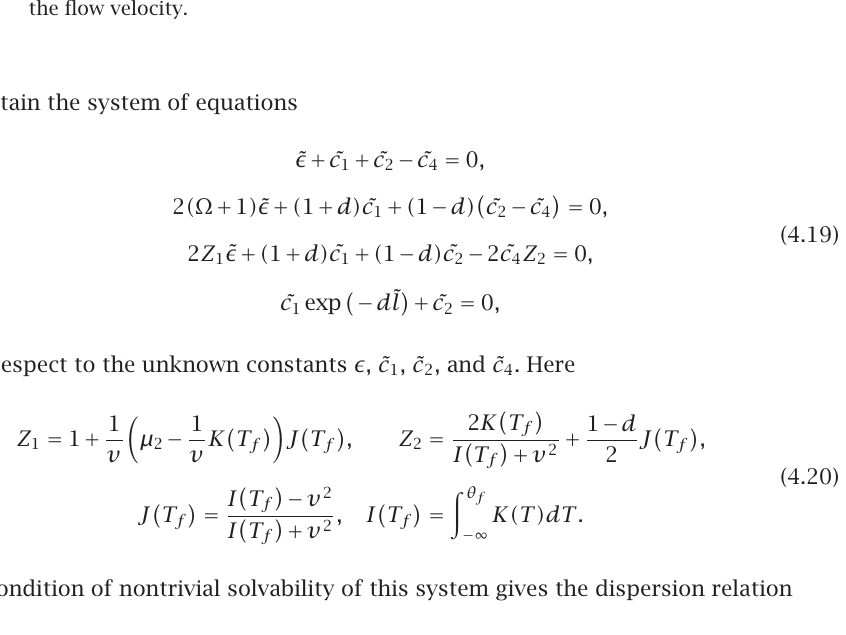
Figure 4.1 . Thermal instability boundary: critical value of Z as a function of the flow